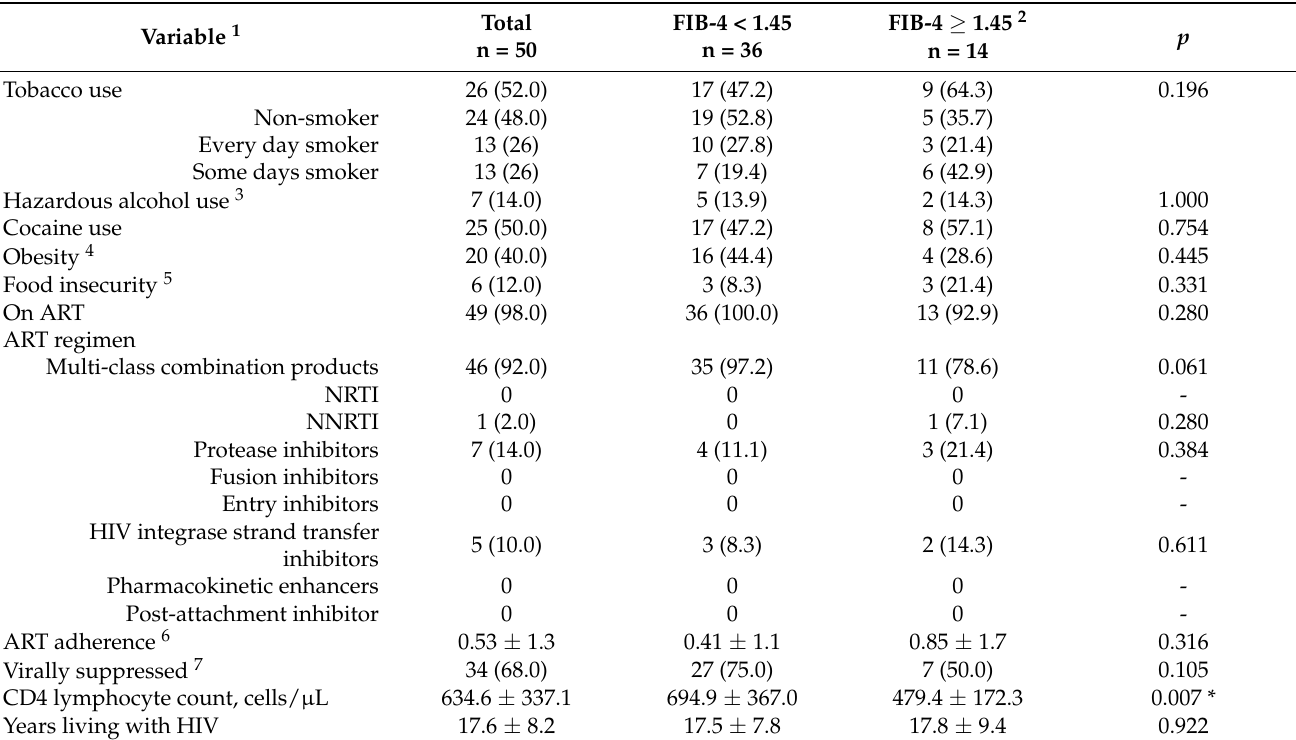
(Table 2). Using Spearman’s correlation, FIB-4 score was significantly inversely correlated